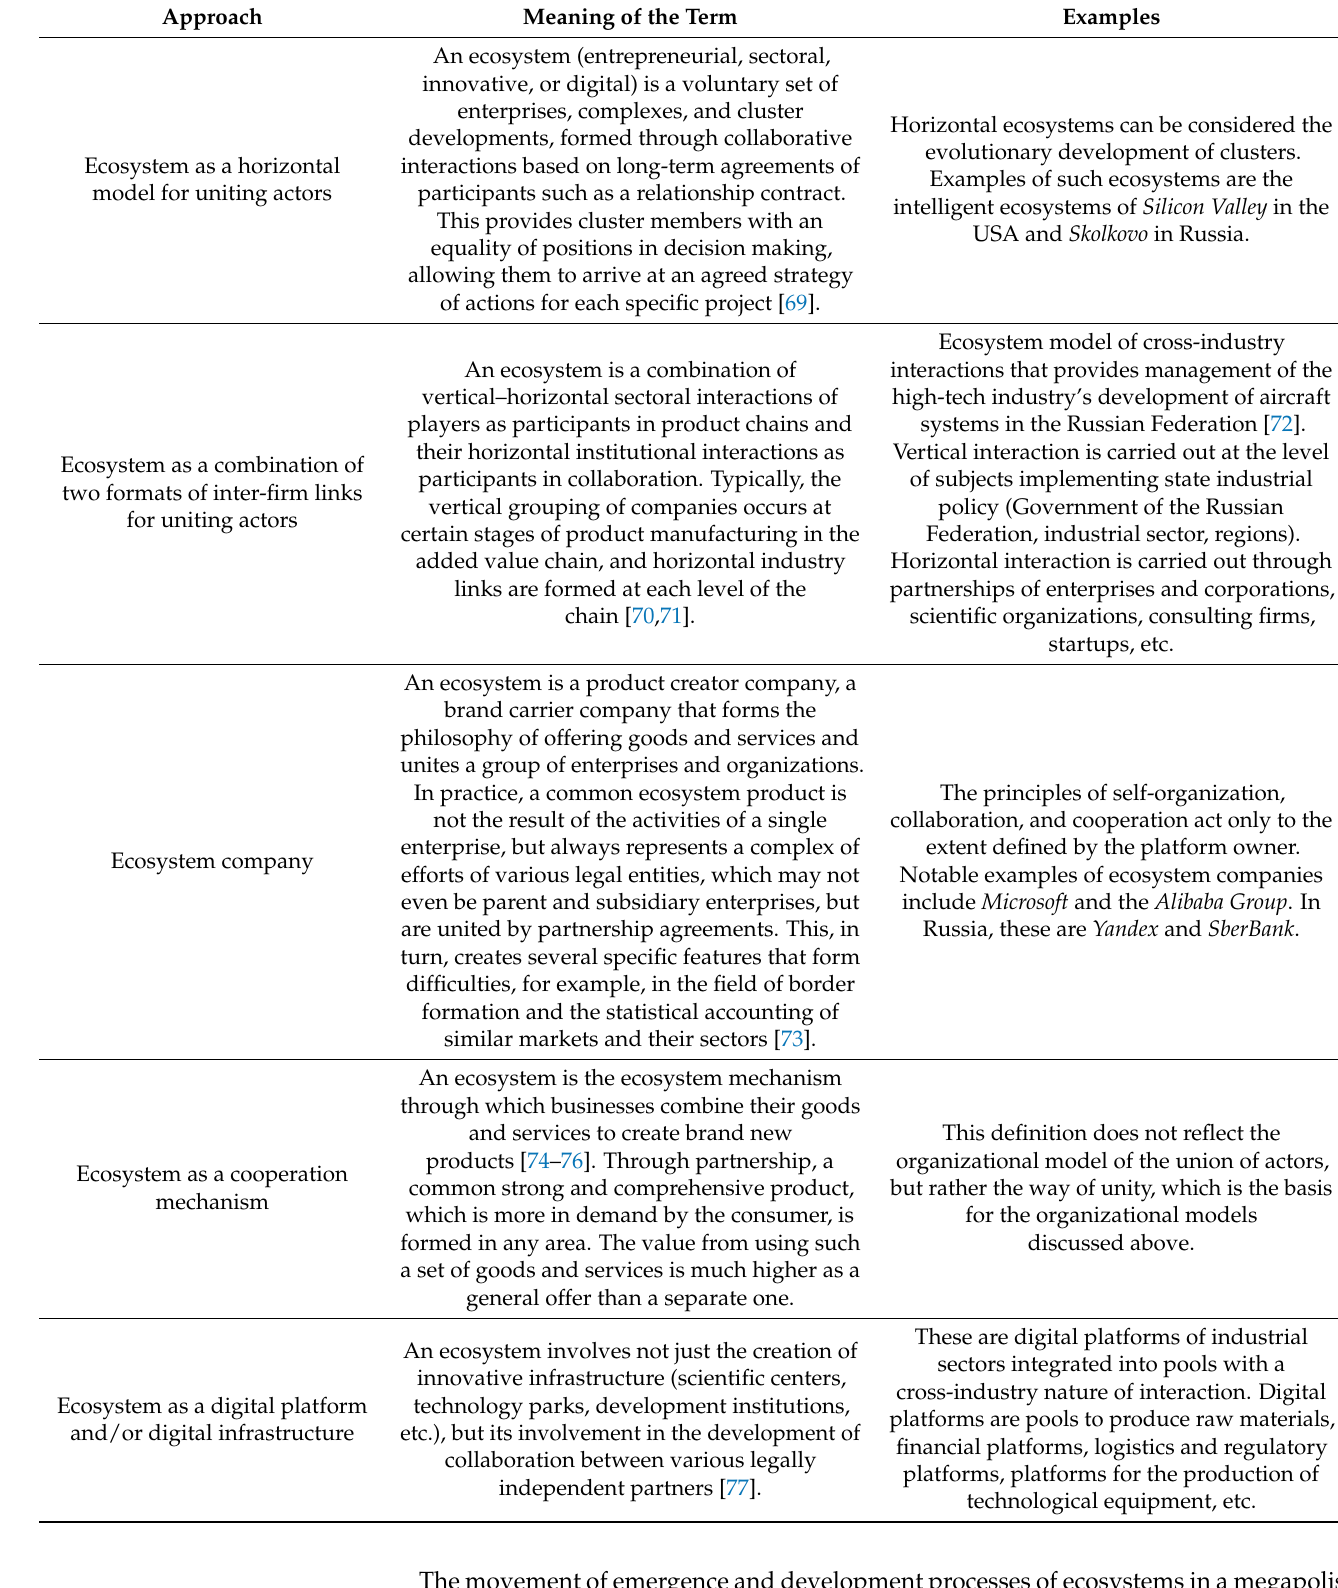
Table 2. Various approaches to the definition of an